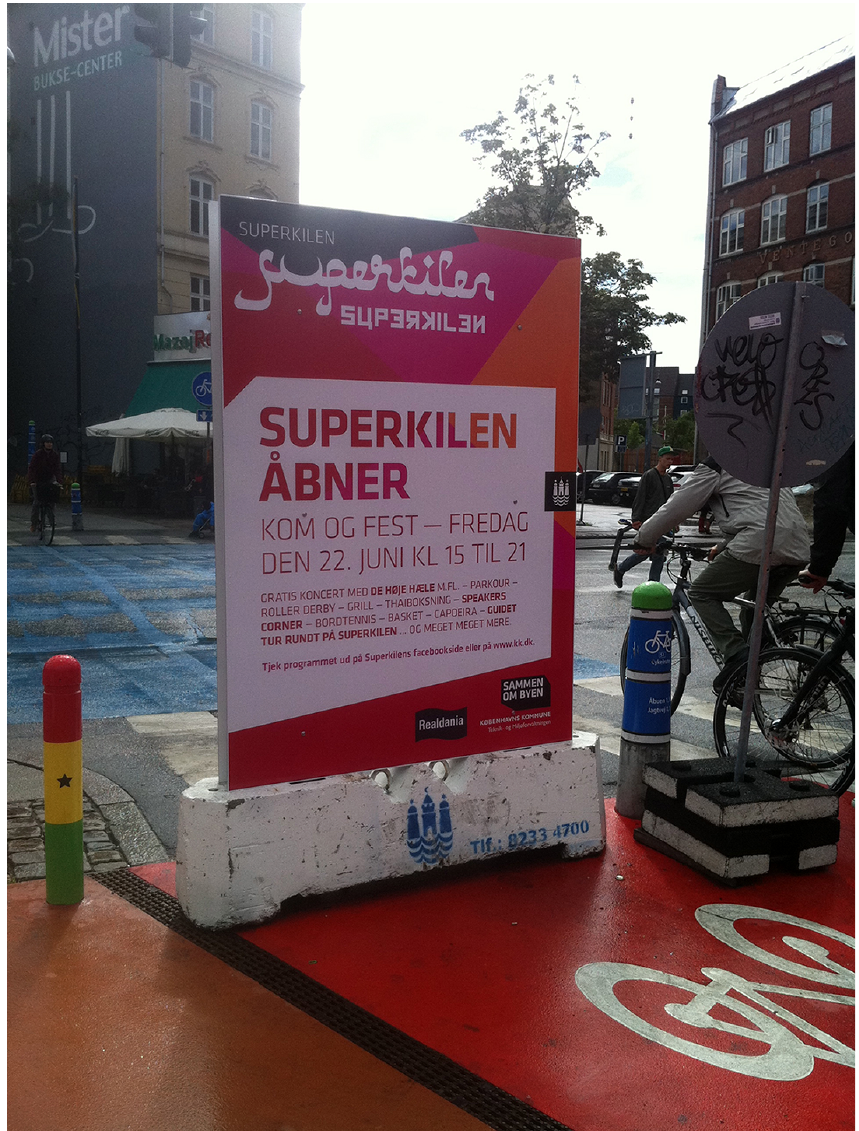
Figure 4. ‘Superkilen is opening: Come and party’: Billboard announcing the opening of Superkilen, June 2012. Photo: Ida